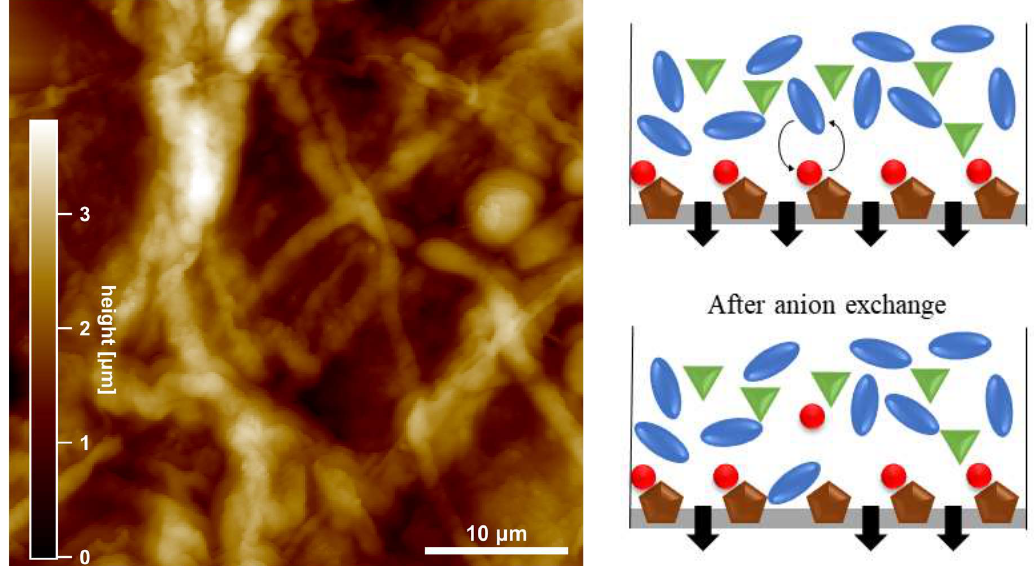
Figure 6. ( Left ) AFM topography of the top side of the membrane PILs BD2 after being used for filtration experiments with a calcium gluconate solution. Bright (dark) colors correspond to large (small) heights. Note the different height scale compared to Figure 5. ( Right ) Scheme of the possible anion exchange causing a decreased flux (brown: imidazolium cation, green: calcium cation, red: bromide, blue: gluconate).